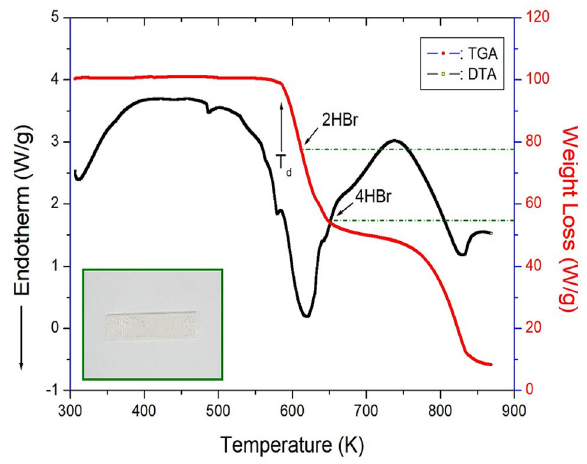
Figure 4. Thermogravimetry and differential thermal analysis curves of [NH 3 (CH 2 ) 2 NH 3 ] 2 CdBr 4 ·2Br.